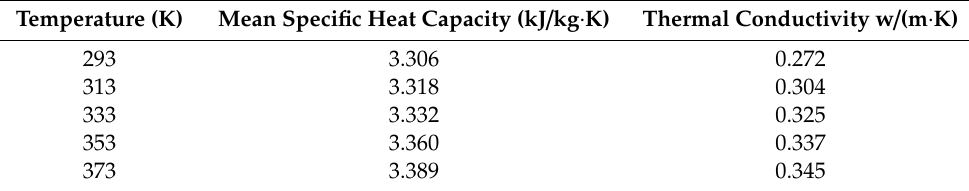
Table 1. Specific heat capacity and thermal conductivity in di ff erent temperature of